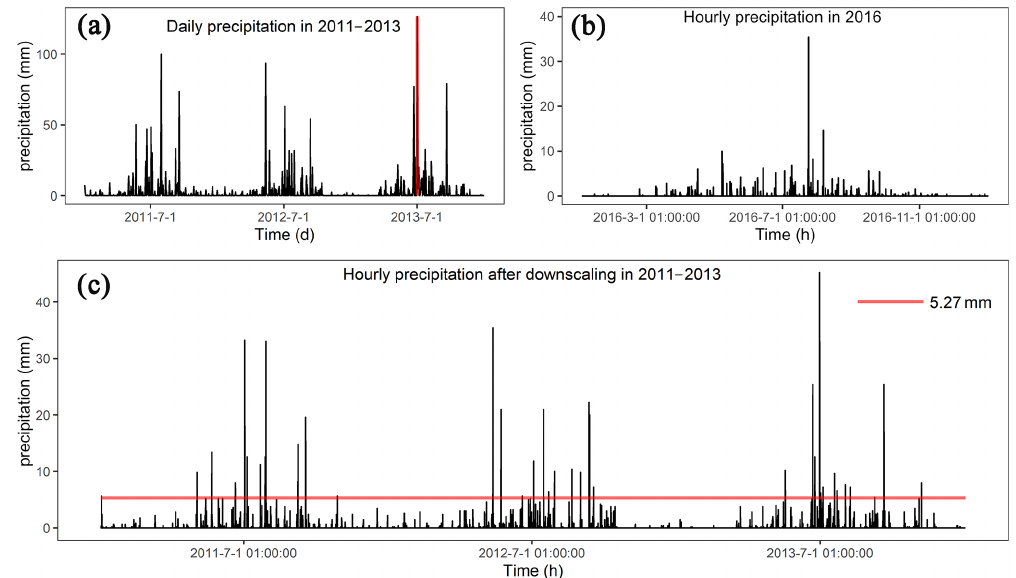
Figure 2. (a) Daily precipitation in 2011–2013 (the red vertical line indicates the maximum daily precipitation of 126.5mm), (b) hourly precipitation in 2016 and (c) downscaled hourly precipitation in 2011–2013 (the horizontal red line indicates the hourly mean precipitation of 5.27mm on the day with the maximum precipitation marked in panel a